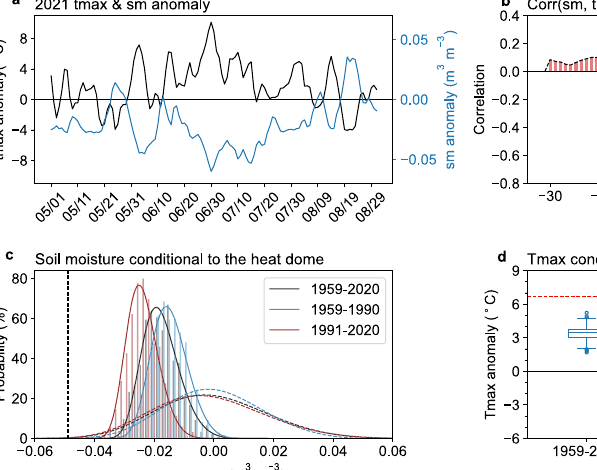
Fig. 5 | The in fl uence of soil moisture on the temperature and circulation in ERA5 reanalysis. a The timeseries of maximum temperature (black, unit: °C) and soil moisture (blue, unit: m 3 m − 3 ) anomalies (relative to the 1981 – 2010 average for each calendar day) during 1 May – 31 August 2021. b The lead-lag correlation betweenmaximumtemperatureand soilmoistureanomaliesin2021.Thenegative values of the x-axis indicate that soil moisture leads to temperature. c Histogram (bars) and probability density functions (PDF, solid curve) of simultaneous soil